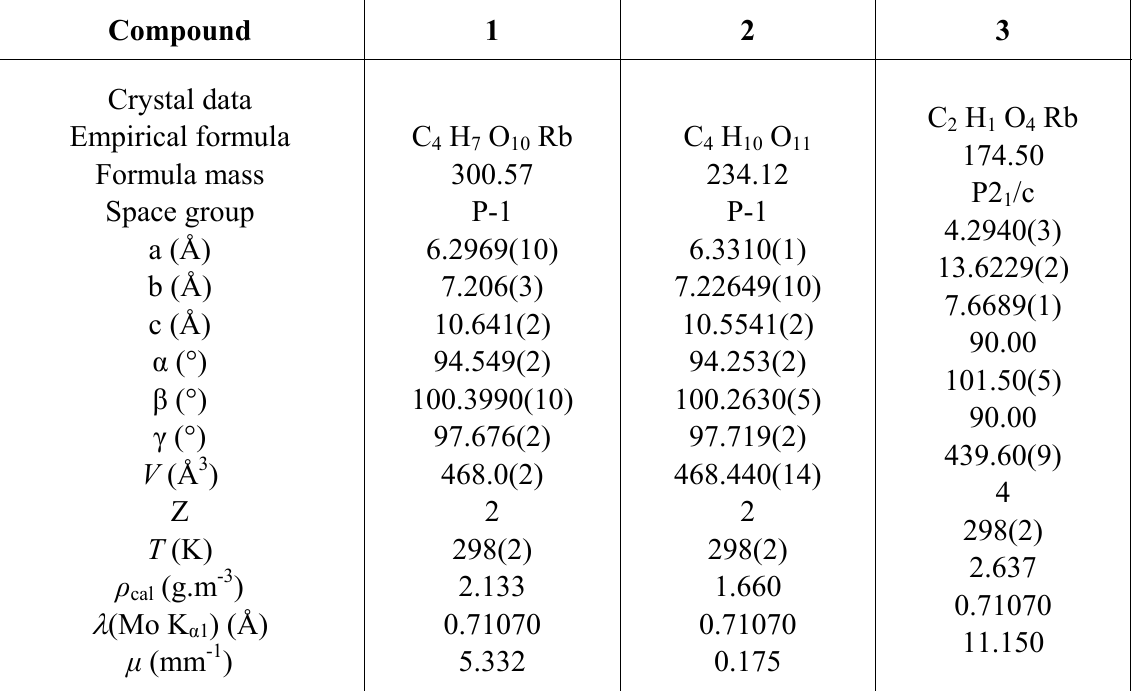
Table 1. Crystallographic data for 1, 2 and 3